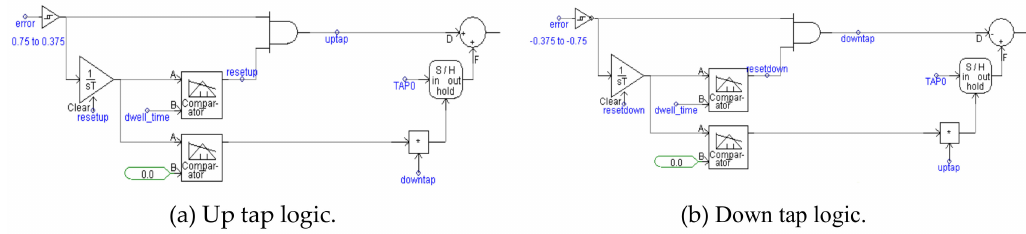
Figure 5. Tap up and tap down logic of SVR.